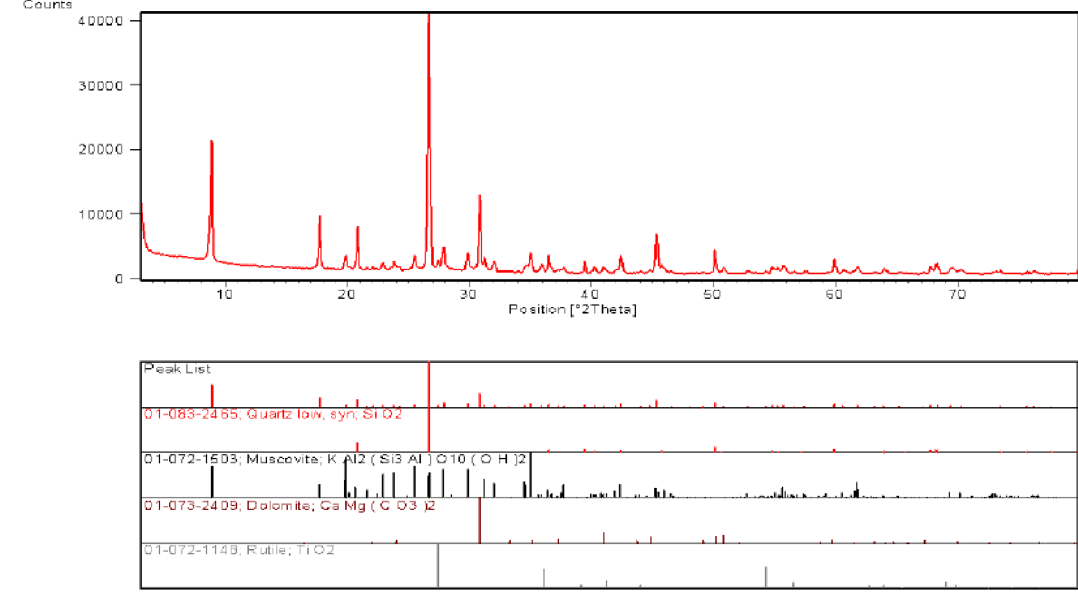
Figure 4. DK80 + 432 XRD sampling test results of left side excavation face.